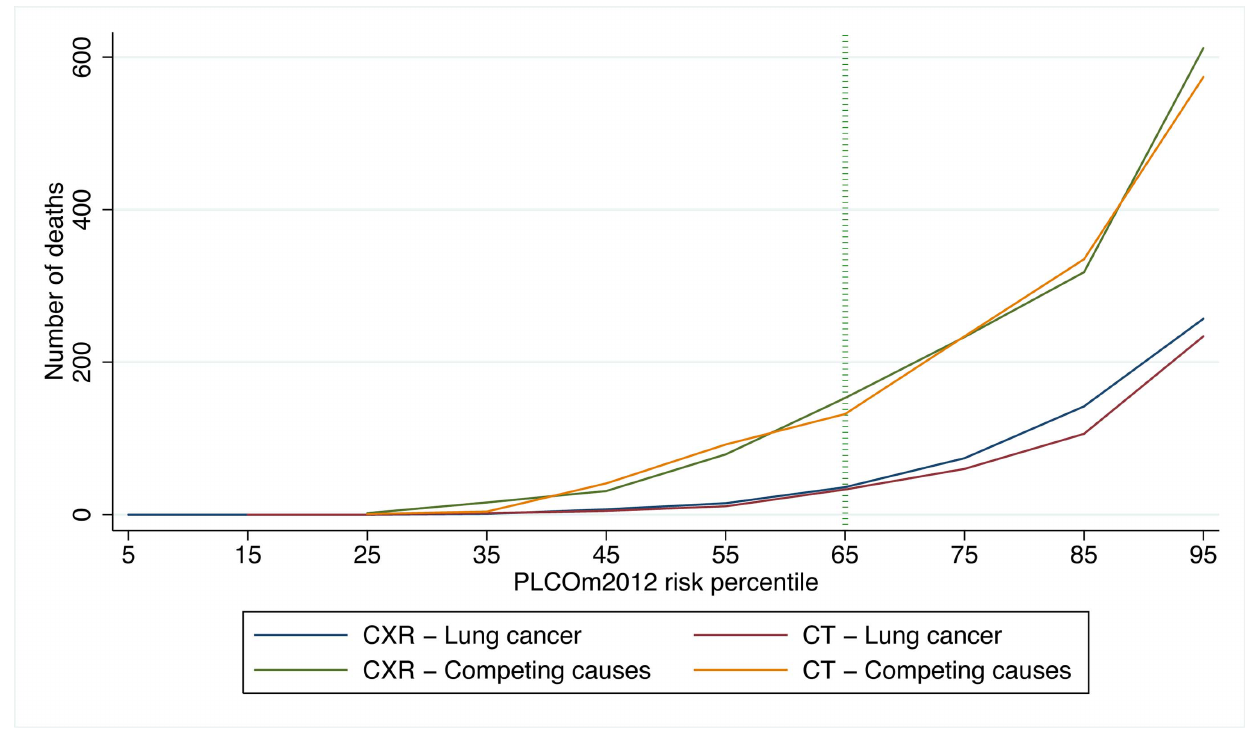
Figure 3. NLST deaths from lung cancer and competing causes by trial arm and decile of PLCO m2012 risk. CT is the LDCT screening arm; CXR is the CXR screening arm. PLCO m2012 refers to the lung cancer risk prediction model described in [11].